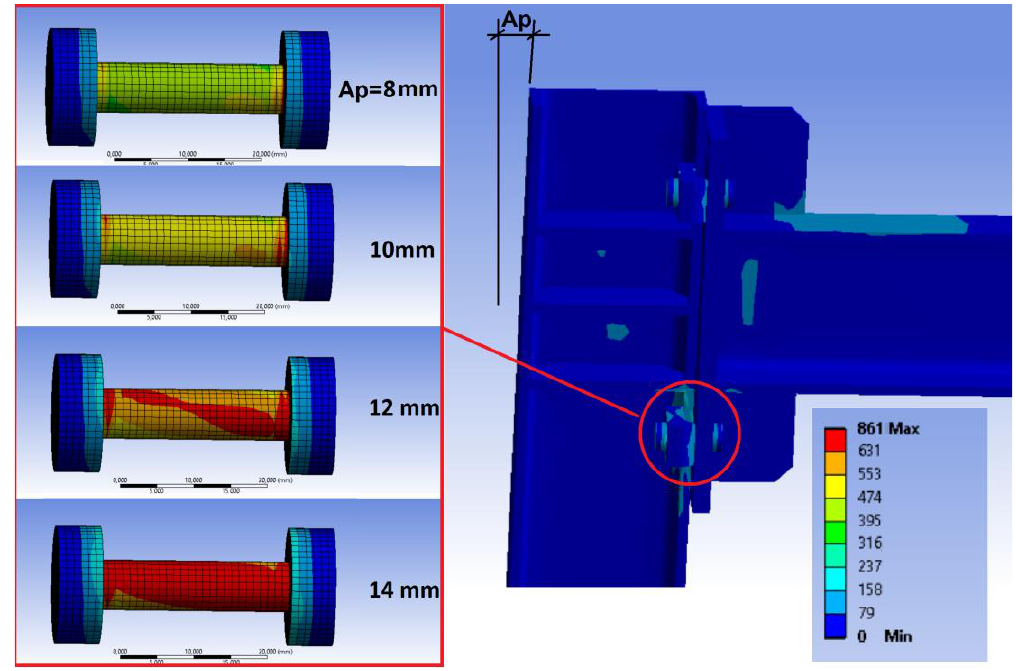
Figure 9. Stress distribution in the bolts of the clamped joint according to the simulation for a displacement value Ap at the top of the frame.